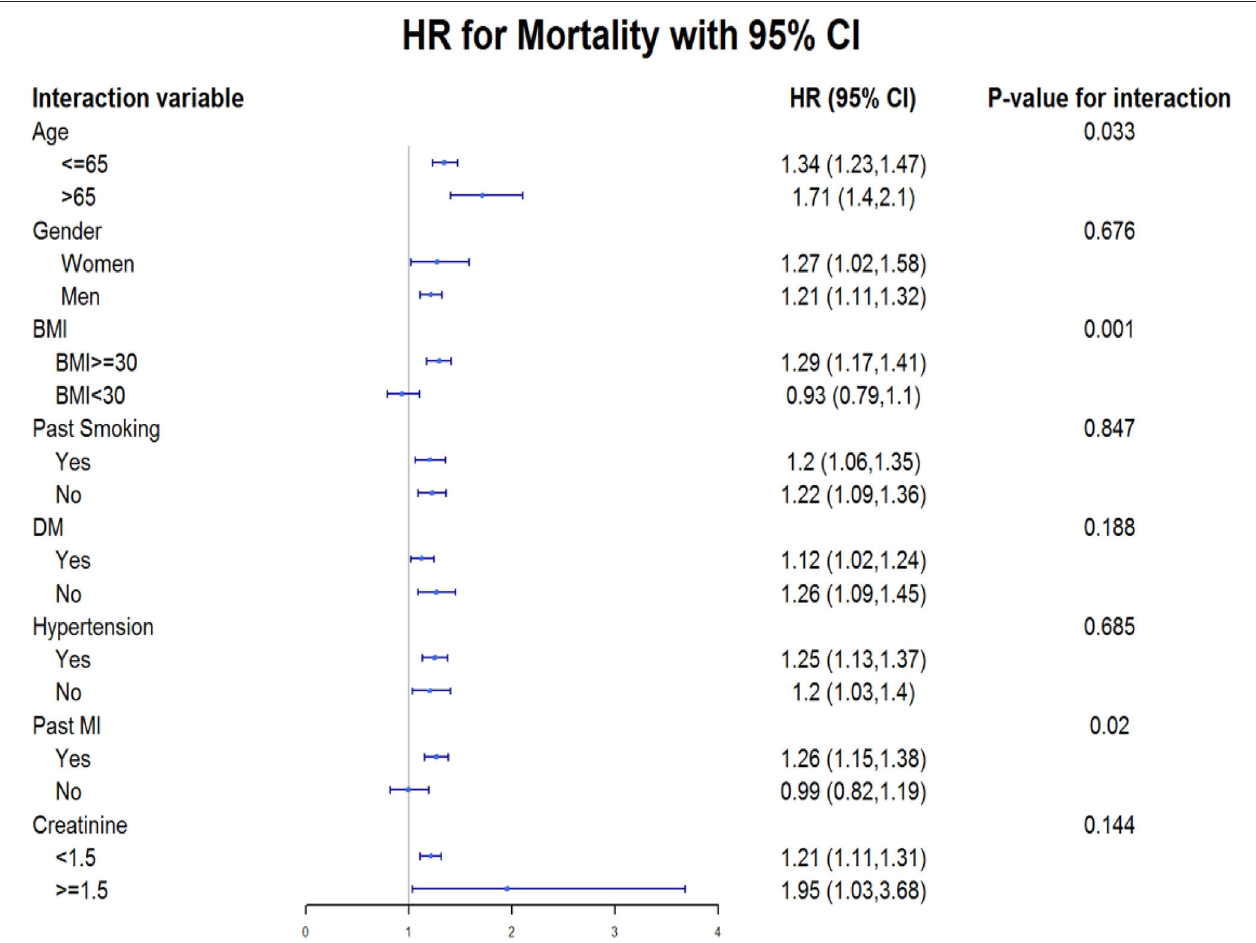
FIGURE 3 | Subgroup analysis predicting the association between 20-year all-cause mortality and Arab ethnicity. HR, Hazard Ratio; CI, Confidence Interval; BMI, Body Mass Index; DM, Diabetes Mellitus; MI, Myocardial